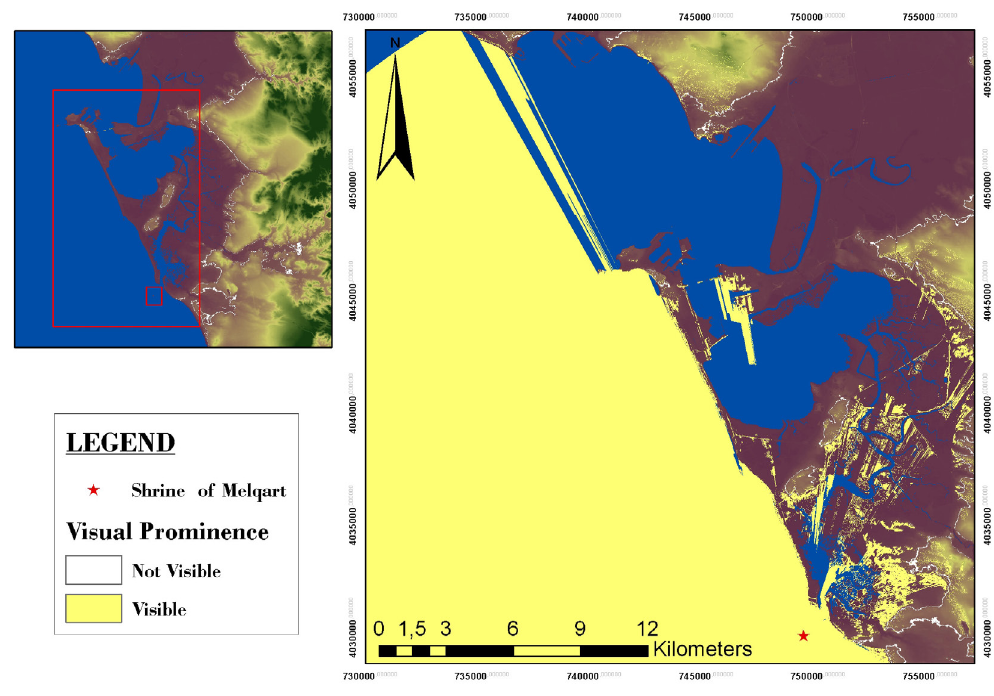
Figure 3. Projection of the GIS analysed viewshed of the temple of Melqart (right). On the left, detail of the orientation and shape of this viewshed integrated into the morphology of the archipelago in Phoenician times.